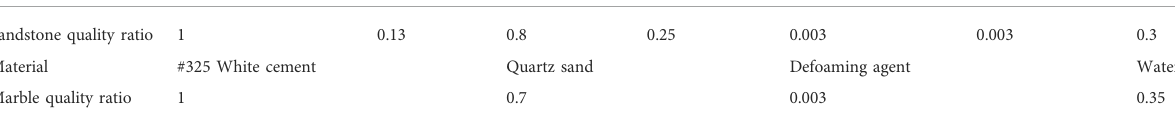
TABLE 1 Material ratios used for preparation of composite rock samples. Material